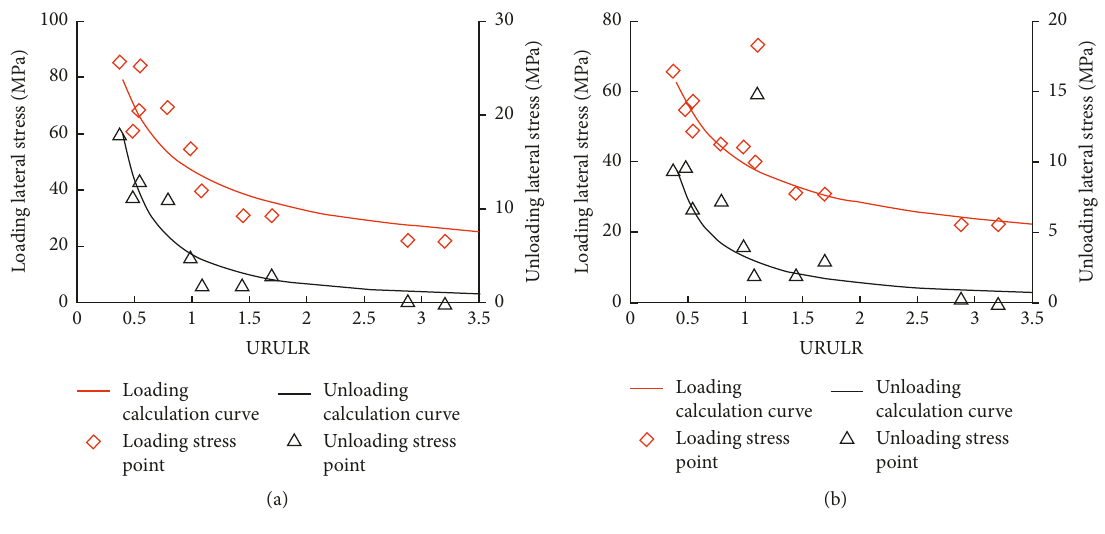
Figure 6: Stress-RURLR curves. (a) Peak stress (b) Yield stress.